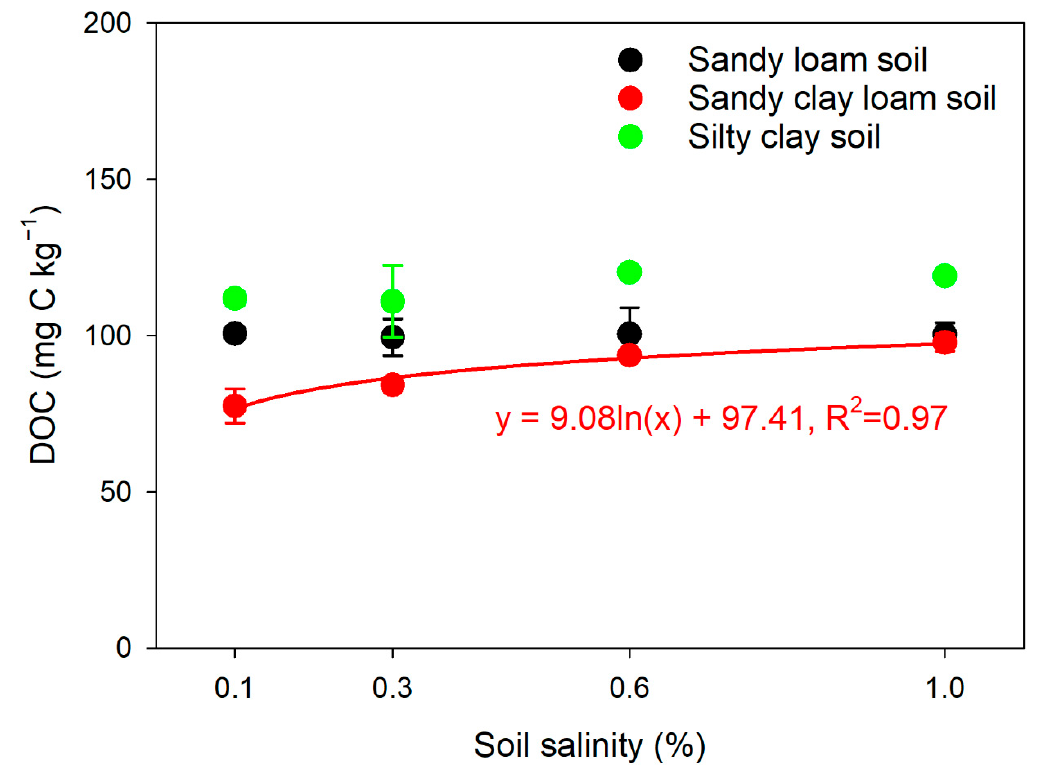
Figure 3. Relationships between dissolved organic carbon (DOC) and salinity in the sandy loam soil, sandy clay loam soil and silty clay soil. Error bars indicate the standard error of the mean ( n = 3).